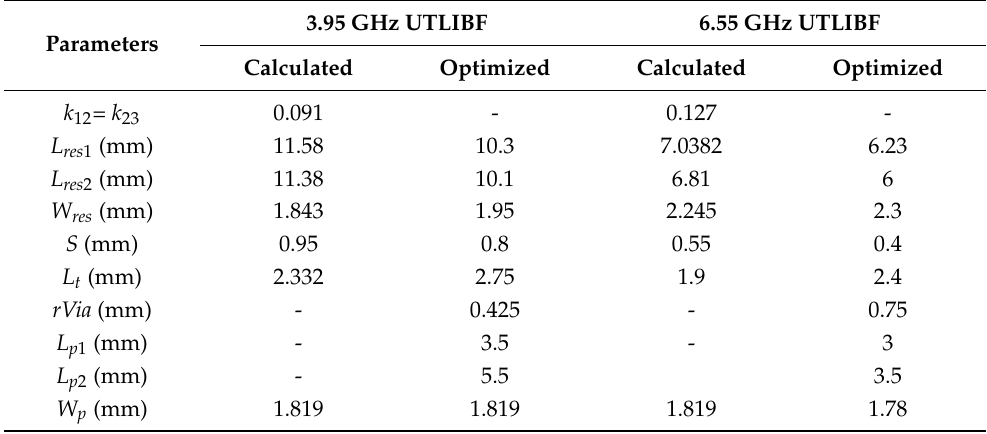
Table 1. Theoretical and optimized parameters of 3.95 GHz and 6.55 GHz UTL IBPFs.